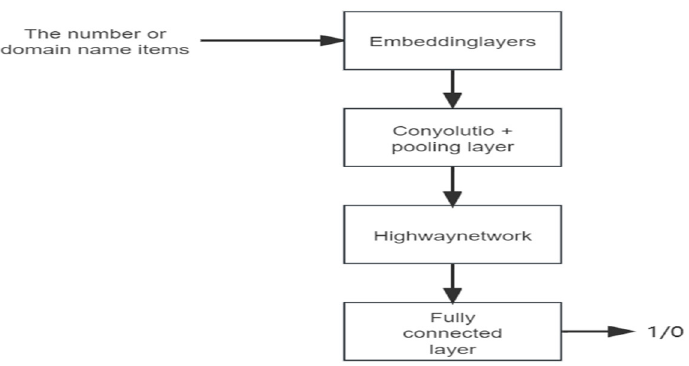
Figure 4. Structure diagram of discriminator.